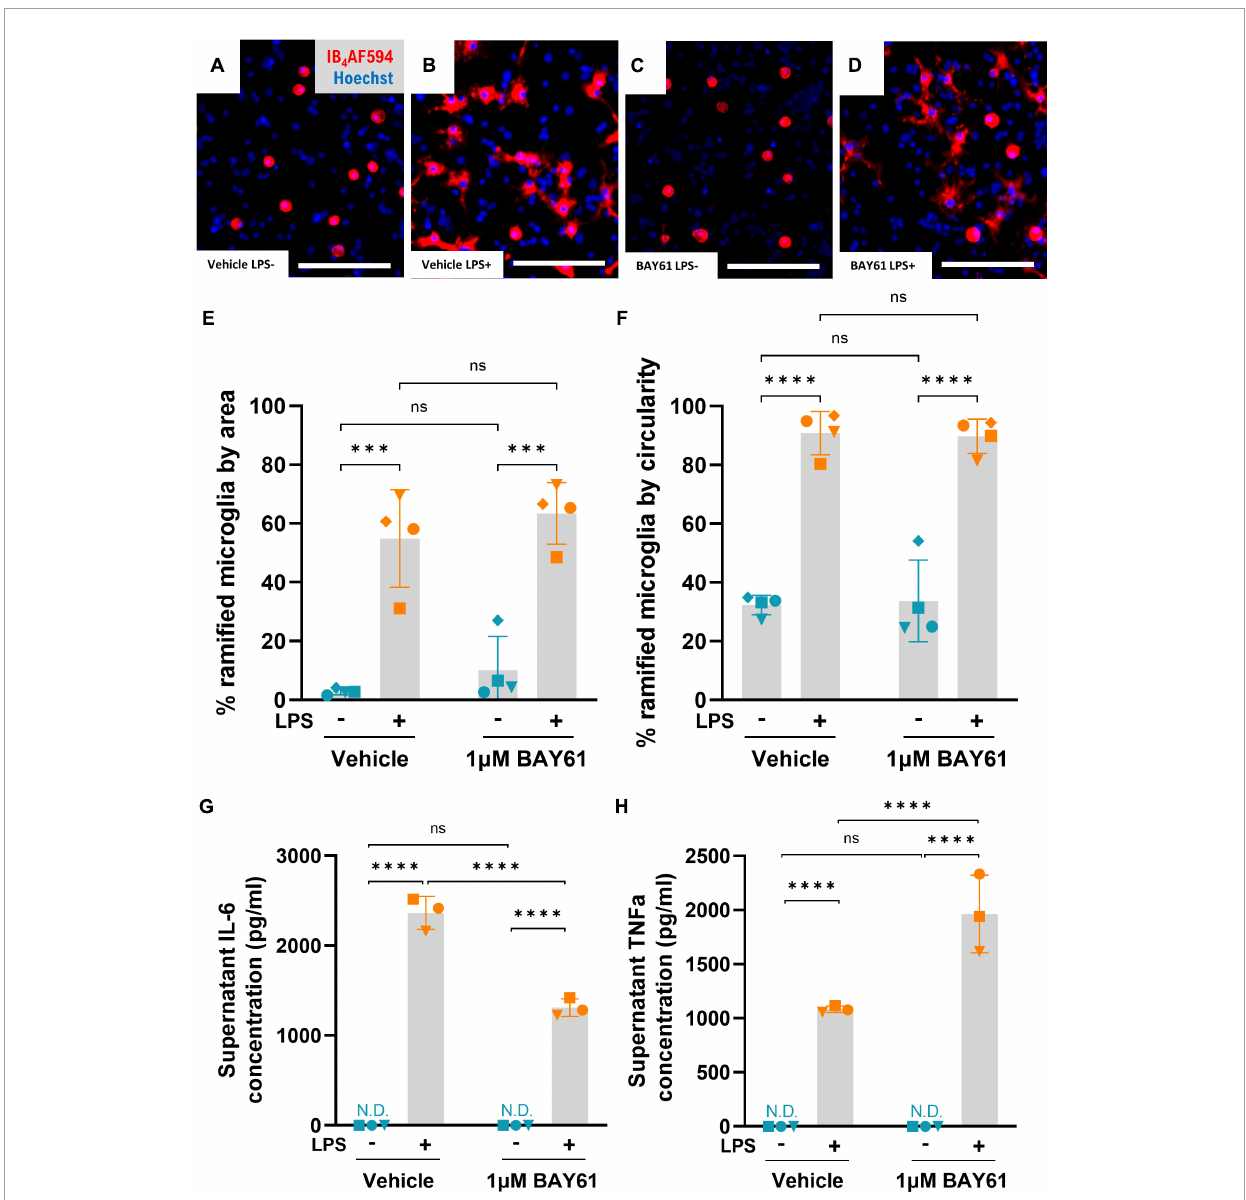
FIGURE5 Syk inhibition has a limited effect on microglial inflammation. (A–D) Representative 10 × images (cropped) of primary rat neuron-glia cultures treated ± BAY61 (1 µ M) and ± LPS (100 ng/ml) for 3 days and stained with Hoechst 33342 and IB 4 -AF594. Scale bars = 50 µ m. (E) Average percentage of microglia that are ramified in images of neuron-glia cultures treated with ± BAY61 (1 µ M) and ± LPS (100 ng/ml) for 3 days (DIV10), as defined by cell area. (F) Average percentage of microglia that are ramified in images of neuron-glia cultures treated with ± BAY61 (1 µ M) and ± LPS (100 ng/ml) for 3 days (DIV10), as defined by cell circularity. (G) Average concentration of IL-6 in supernatants from neuron-glia cultures treated ± BAY61 (1 µ M) and ± LPS (100 ng/ml) for 3 days (DIV10). (H) Average concentration of TNF α in supernatants from neuron-glia cultures treated ± BAY61 (1 µ M) and ± LPS (100 ng/ml) for 3 days (DIV10). All panels: each datapoint represents the mean of three technical replicates. Number of biological repeats = number of datapoints per column. ∗∗∗ p < 0.001, ∗∗∗∗ p < 0.0001. N.D. = not detectable. RM 2-way ANOVA with Šídák’s post-hoc